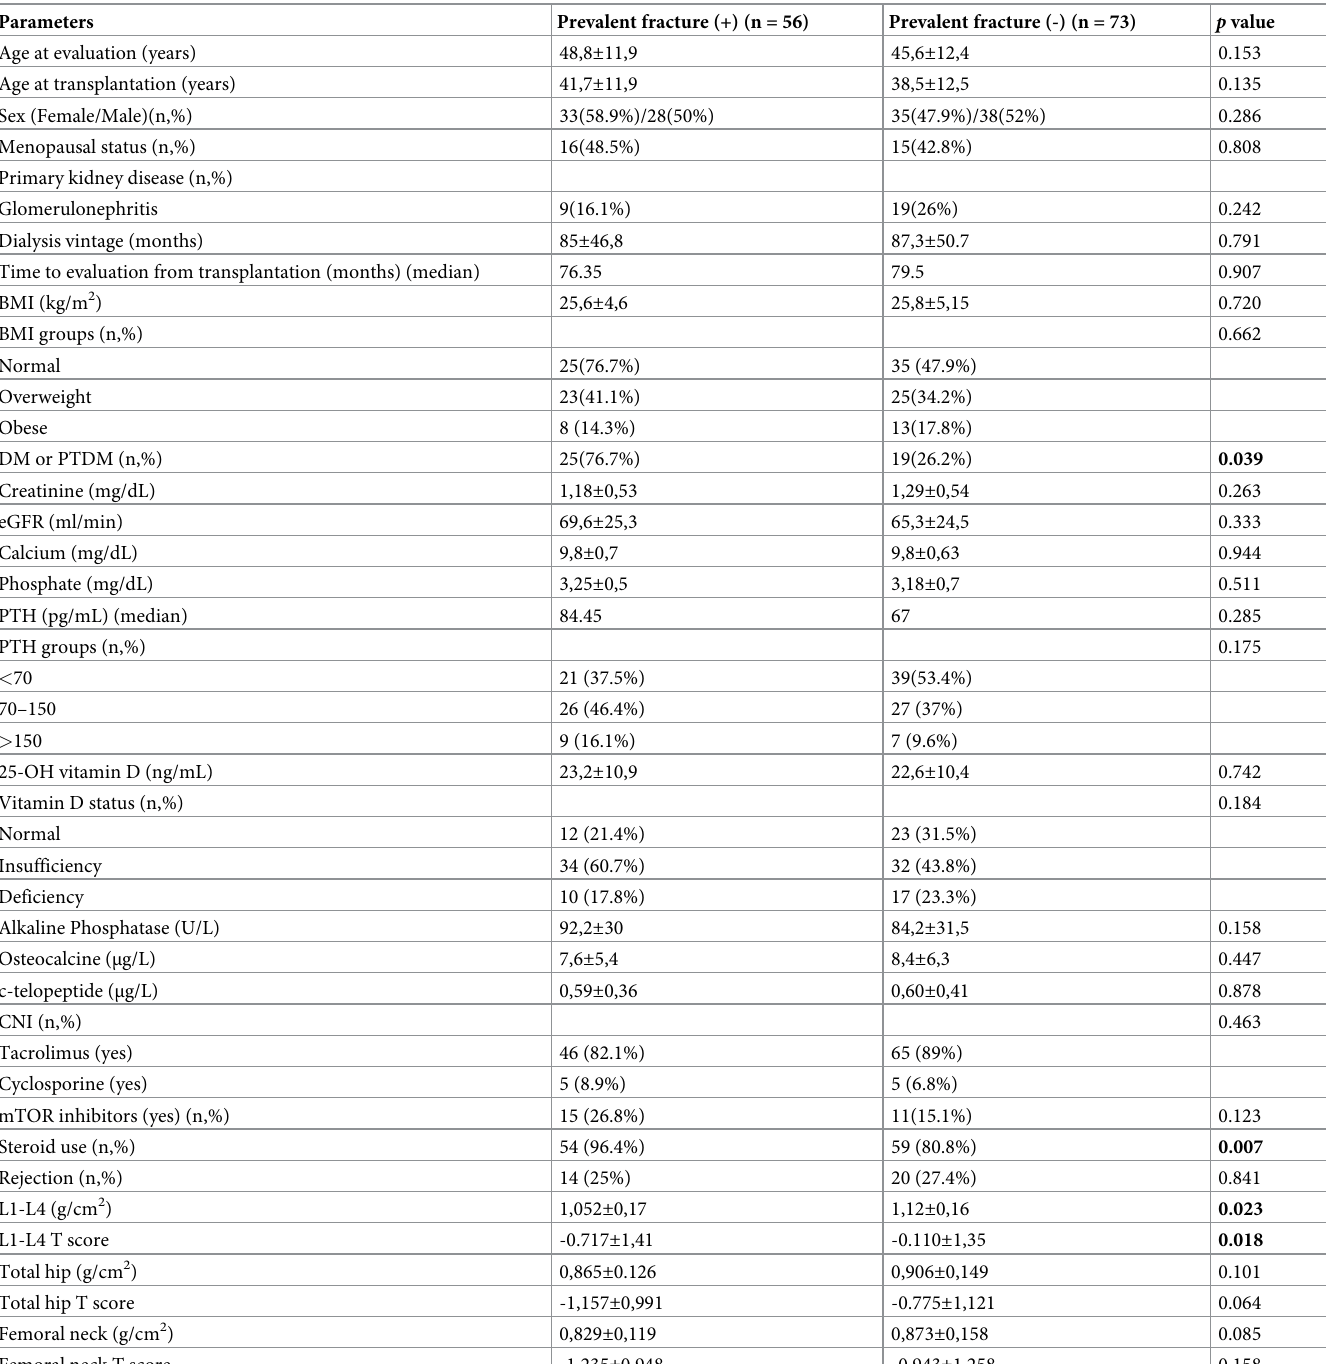
Table 4. Characteristics of the patients and vertebral